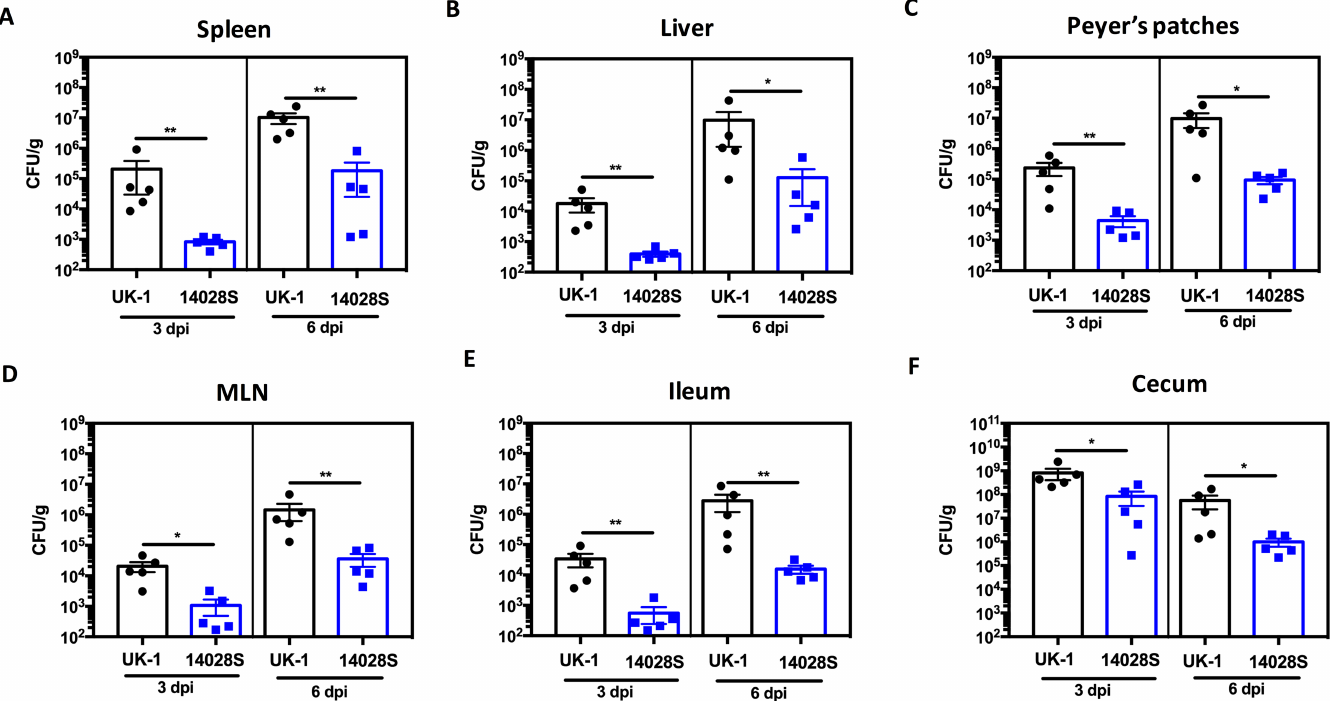
Fig 4. Co-infection with UK-1 and 14028S. BALB/c mice were orally challenged with a 1:1 mixture of 1 x 10 9 CFU of UK-1(Nal r ) and 14028S(Cm r Tc r ). Groups of mice (n = 5 per group) were euthanized on days 3 and 6 post challenge. (A) Spleen, (B) liver, (C) Peyer’s patches, (D) MLN, (E) ileum, and (F) cecum were collected to determine the bacterial burdens. Significantly higher UK-1 burdens were observed in all tested organs on both day 3 and 6 compared to 14028S burdens. (cid:3) P (cid:20) 0.05, (cid:3)(cid:3) P (cid:20)